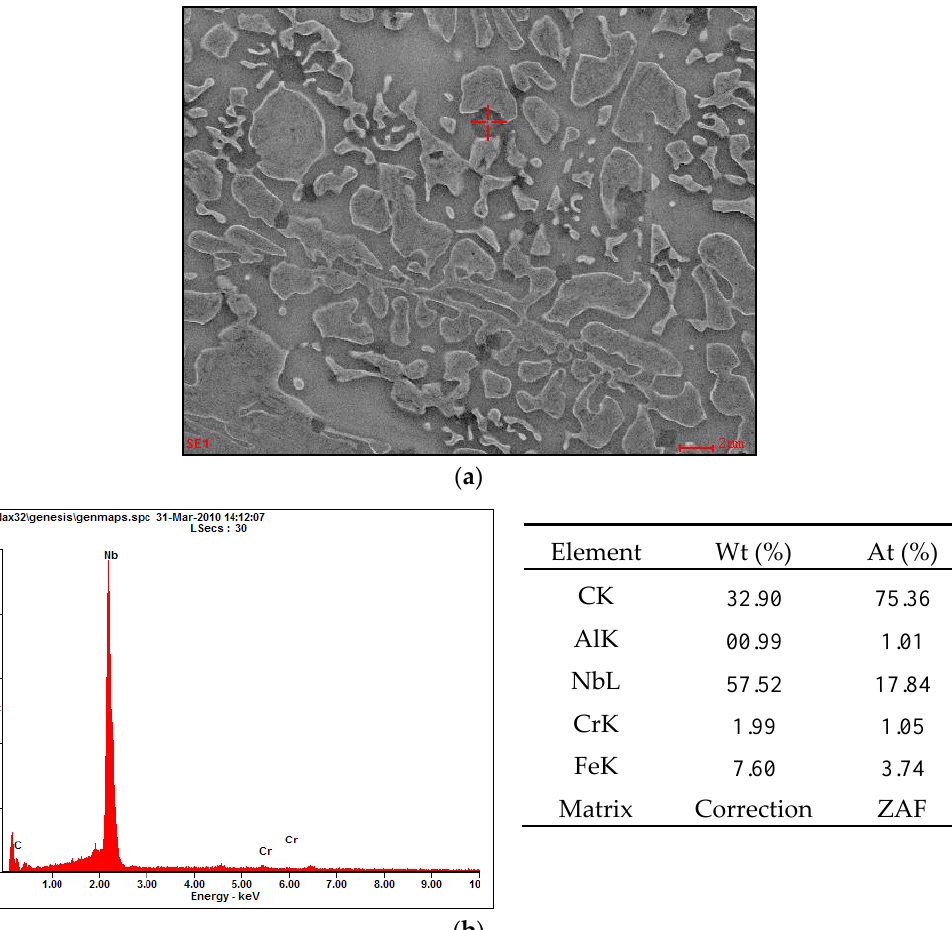
Figure 10. ( a ) SEM image of the nanostructural layered microstructure over the EDS analysis area — a precipitation of niobium carbide; ( b ) the EDS spectrum with the above indicated spot-separation of niobium carbide and results of the quantitative elemental analysis.